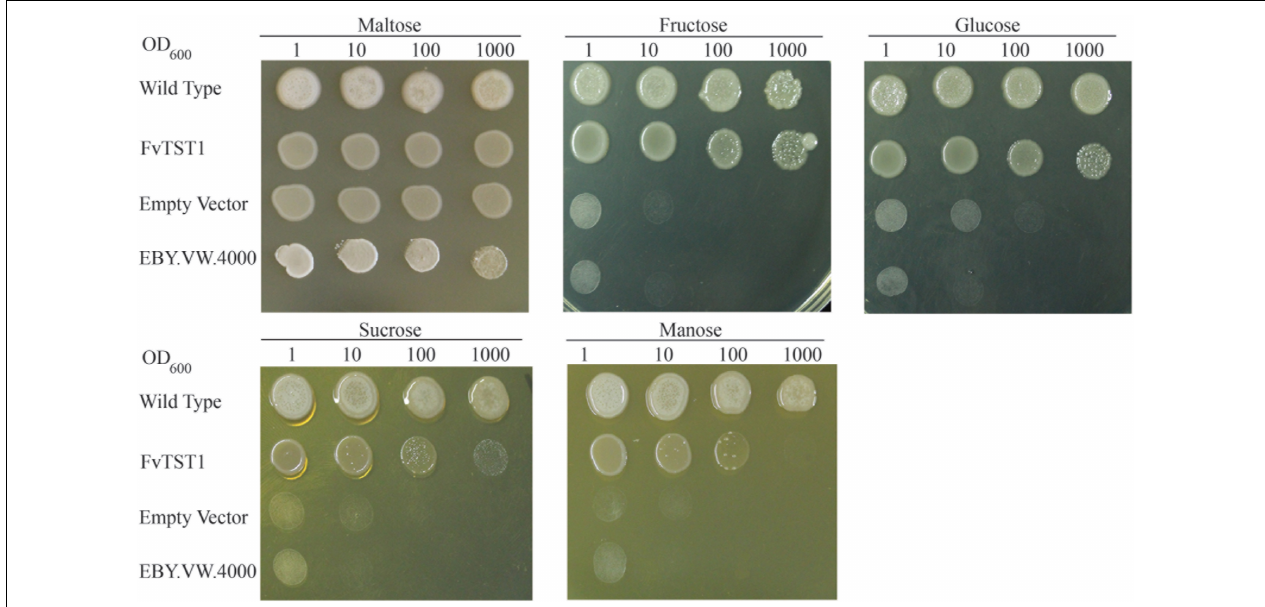
FIGURE 2 | Sugar transport function analysis of FvTST1 in yeast mutant strain EBY.VW.4000. Yeast cells were diluted serially (10-, 100-, and 1,000-fold) and were spotted in a minimal solid medium for 2 days at 30 ◦ C, with 2% maltose, fructose, glucose, sucrose, and mannose as sources of carbon. The wild-type yeast was used as a positive control, and EBY.VW.4000 and empty vector were used as negative